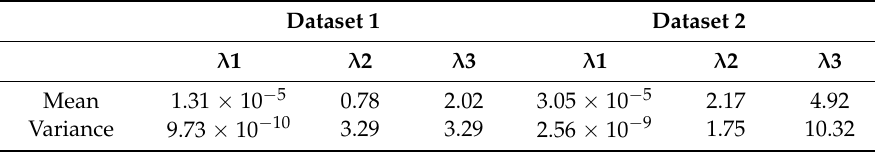
Table 3. Mean and variance of all the eigenvalues of the